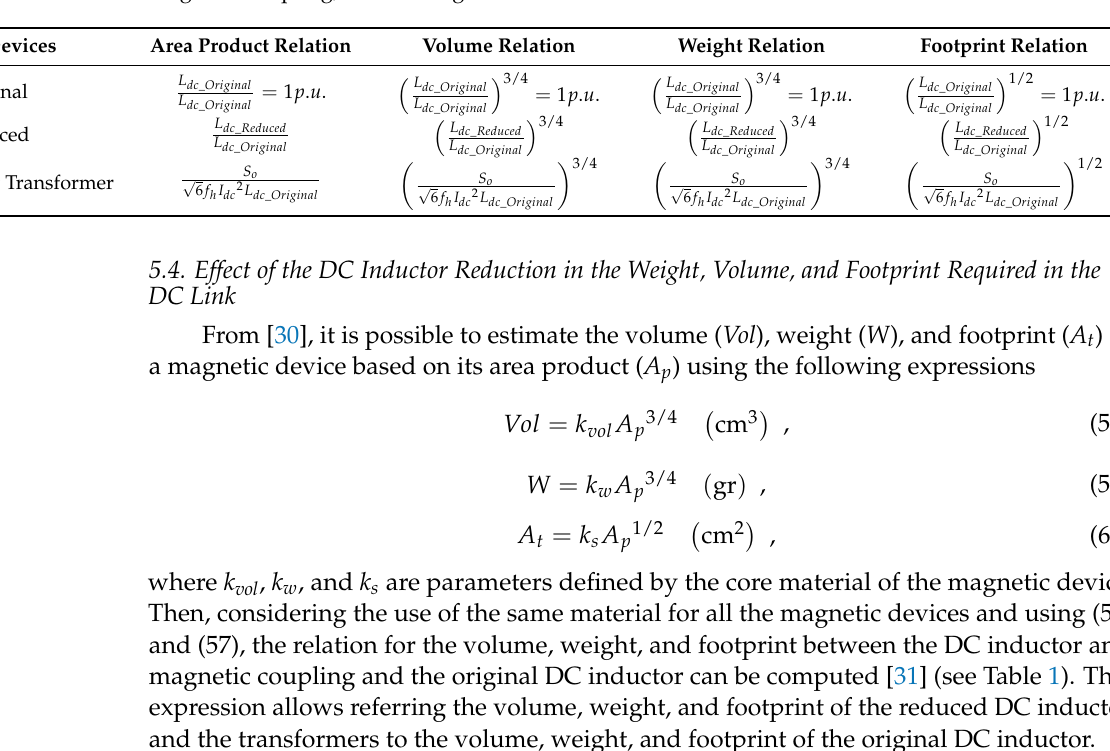
Table 1. Relation of area product, volume, weight, and footprint between reduced DC inductor and magnetic coupling, and the original DC